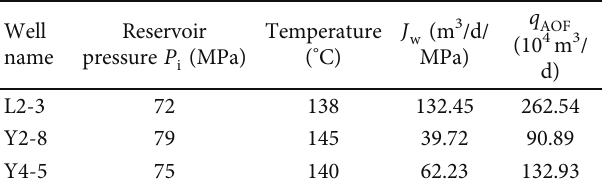
Table 3: Calculation parameters and results of water production index analytical method.